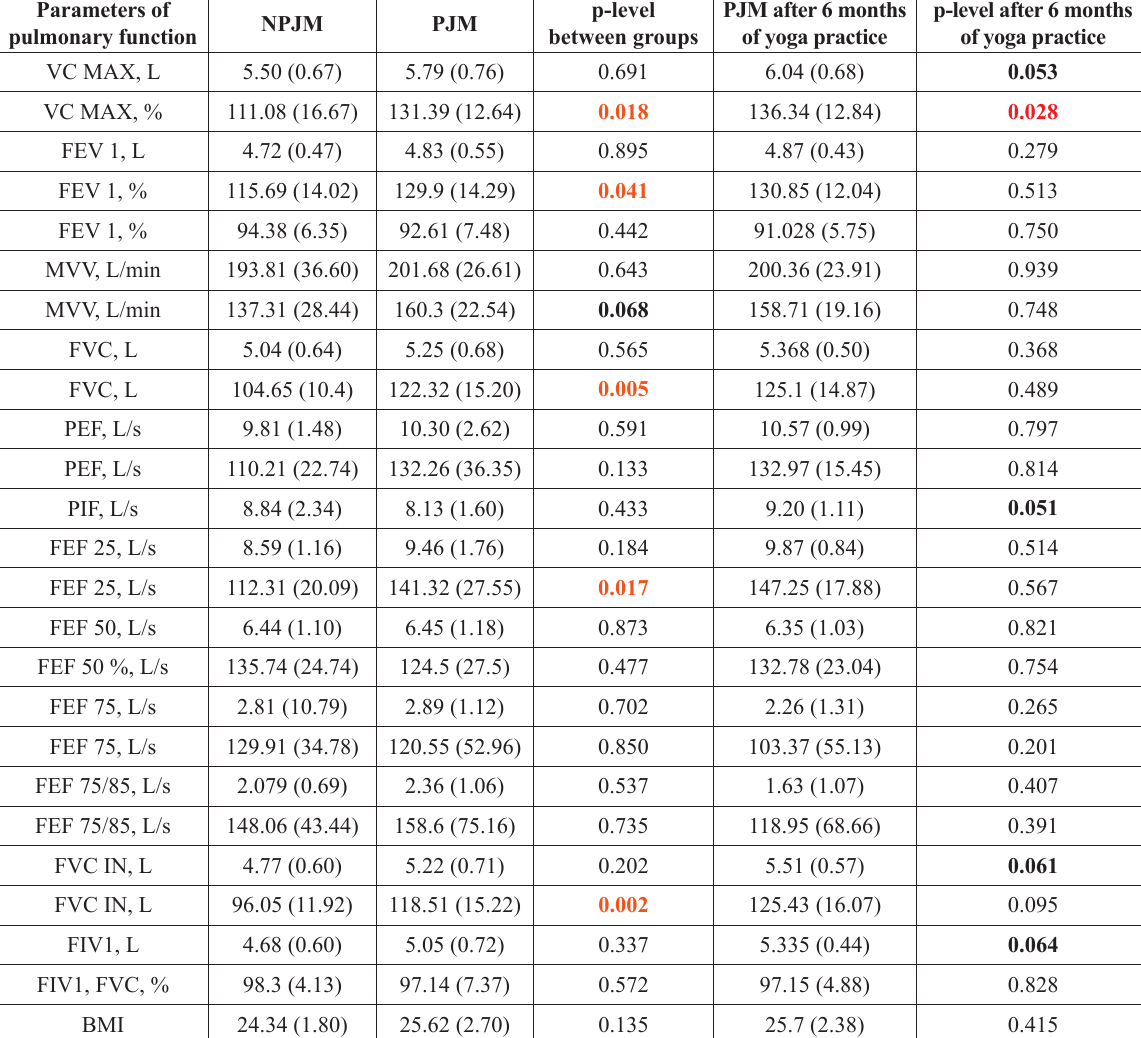
Table 2. Parameters of pulmonary function of men in the control group and in yoga practice group Parameters of NPJM PJM pulmonary function